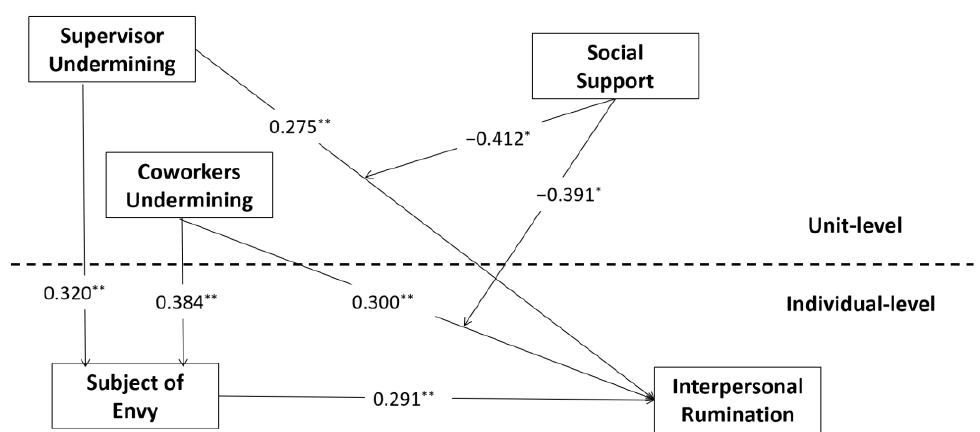
Figure 2. Hypothesis testing results.